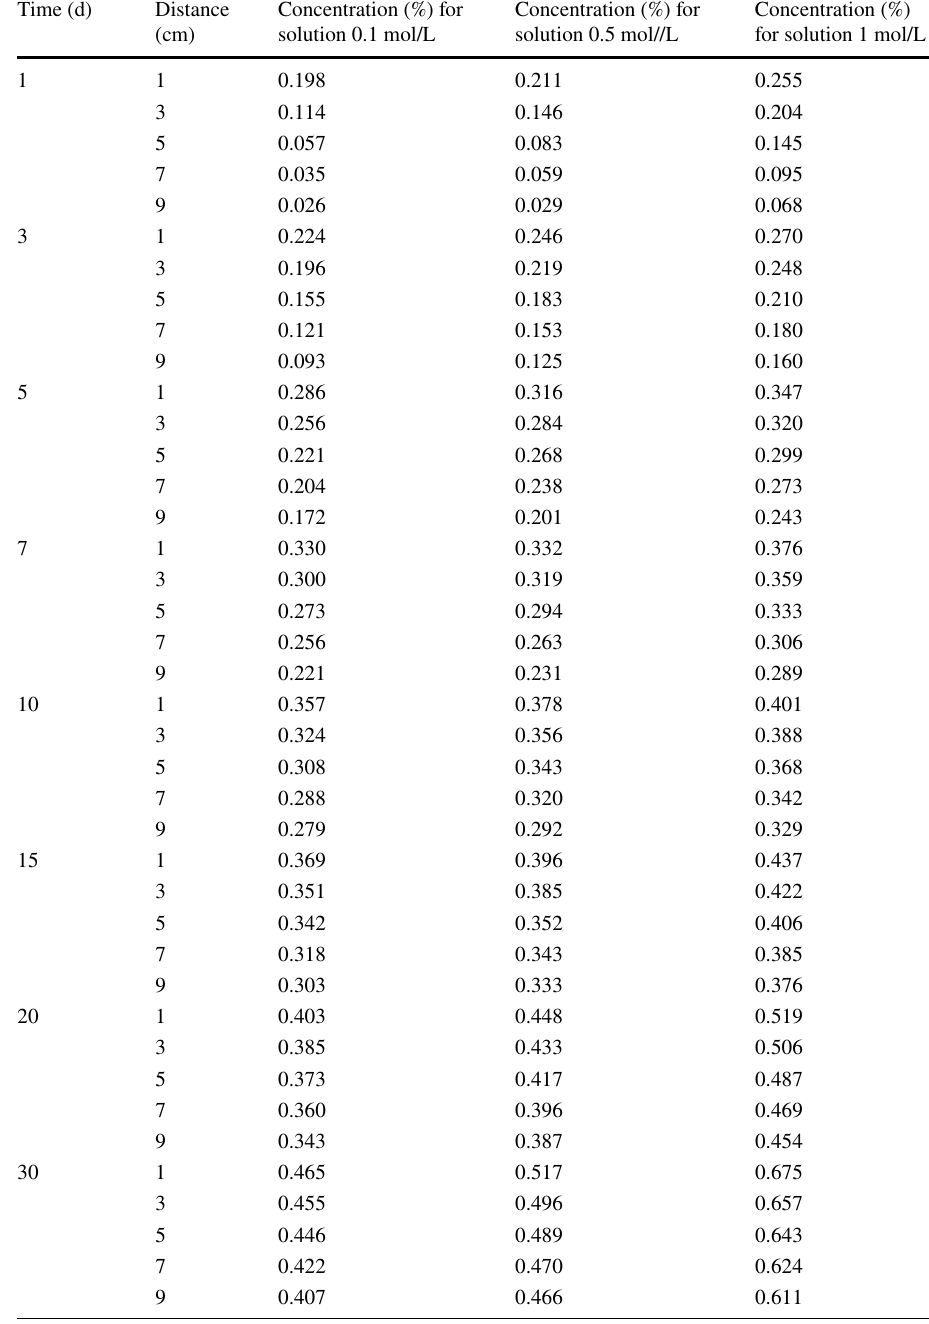
Time (d) Distance Concentration (%) for (cm) solution 0.1 mol/L